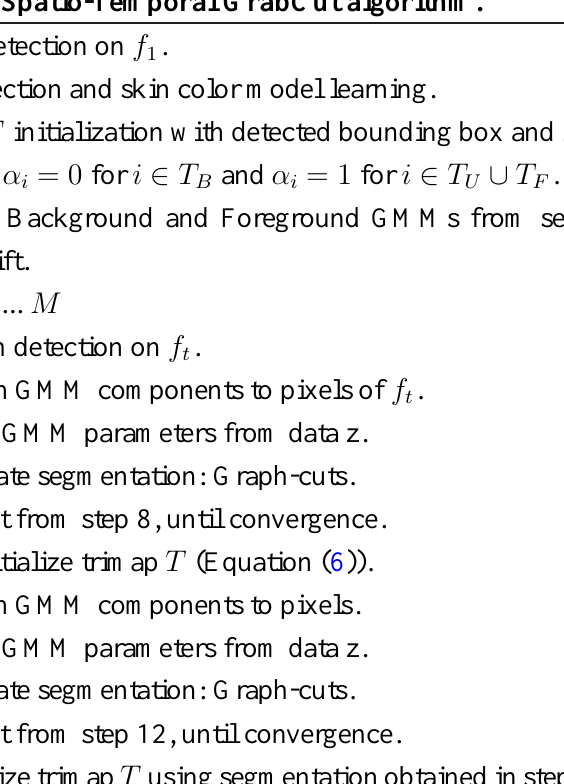
Algorithm 2 Spatio-Temporal GrabCut